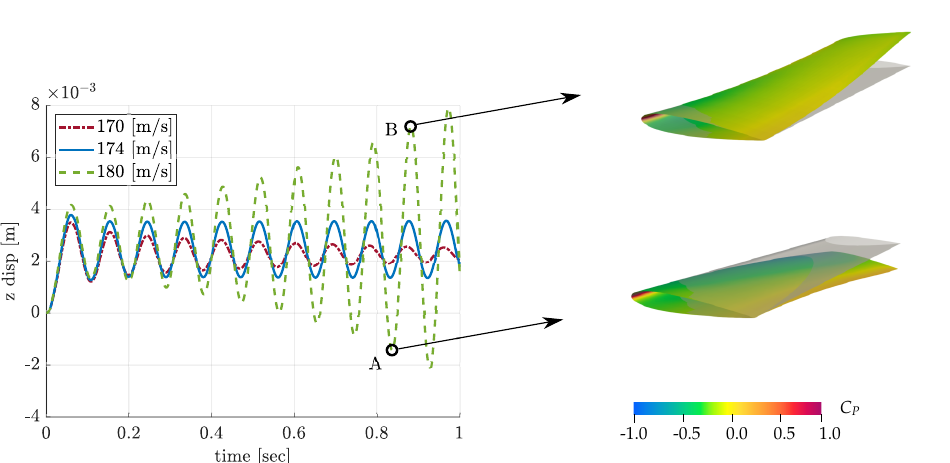
Figure 8. Time history of the Goland’s wing-tip deflection evaluated with surface panels aerodynamic mesh at three different wind speeds.